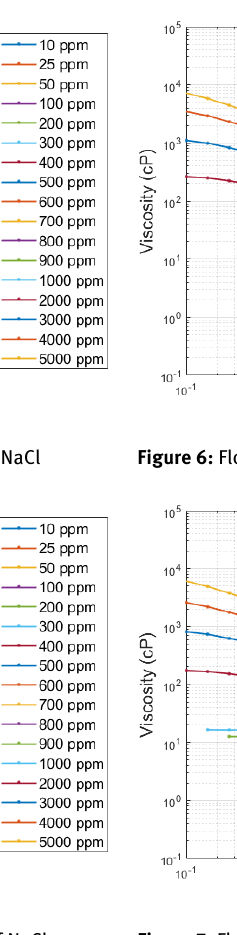
Figure 4: Flow curves graph at 23 ∘ C and 110,000 ppm of NaCl